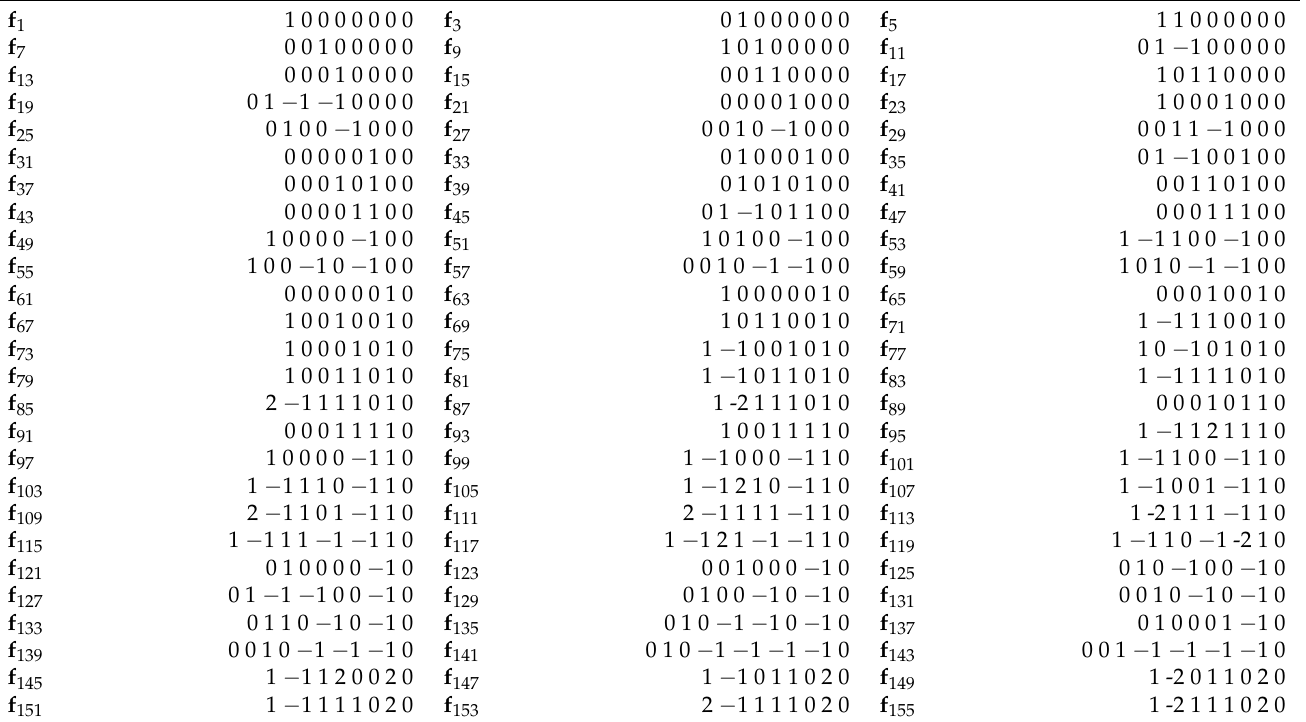
Table 3. The facet vectors ± f i of P ( Q 1 )